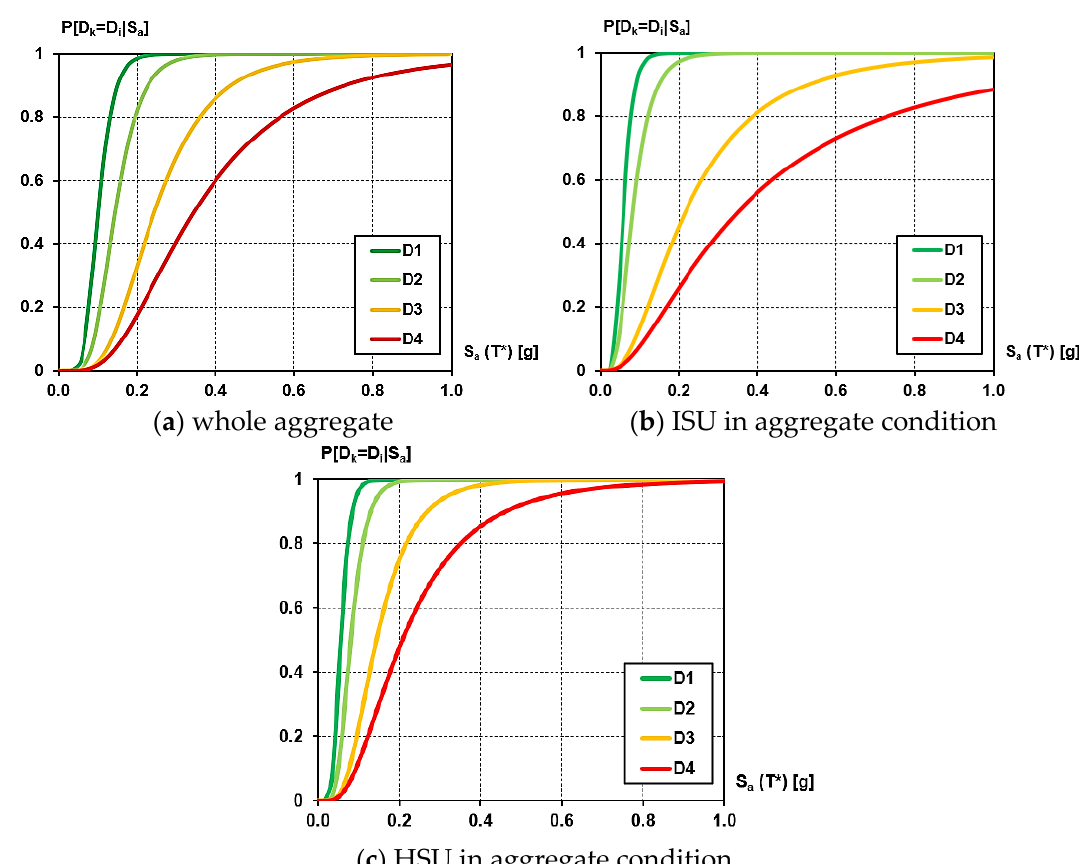
Figure 14. Typological fragility functions derived for the whole aggregate ( a ), the intermediate S.U. ( b ), and the head S.U. ( c ).